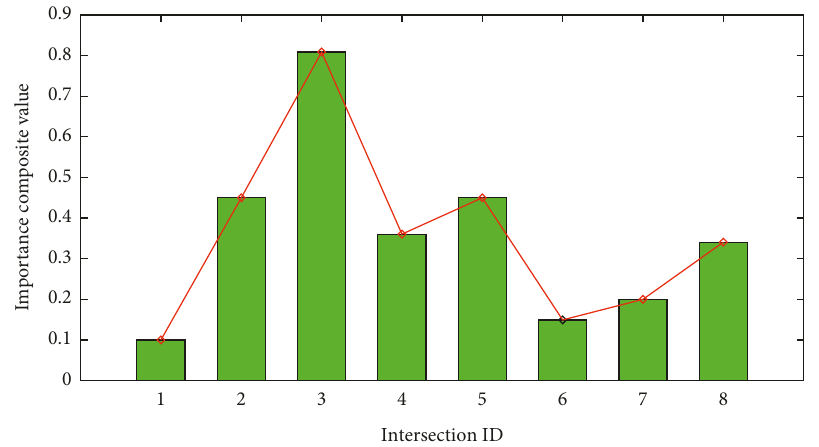
Figure 1: Comprehensive value of the importance of traffic